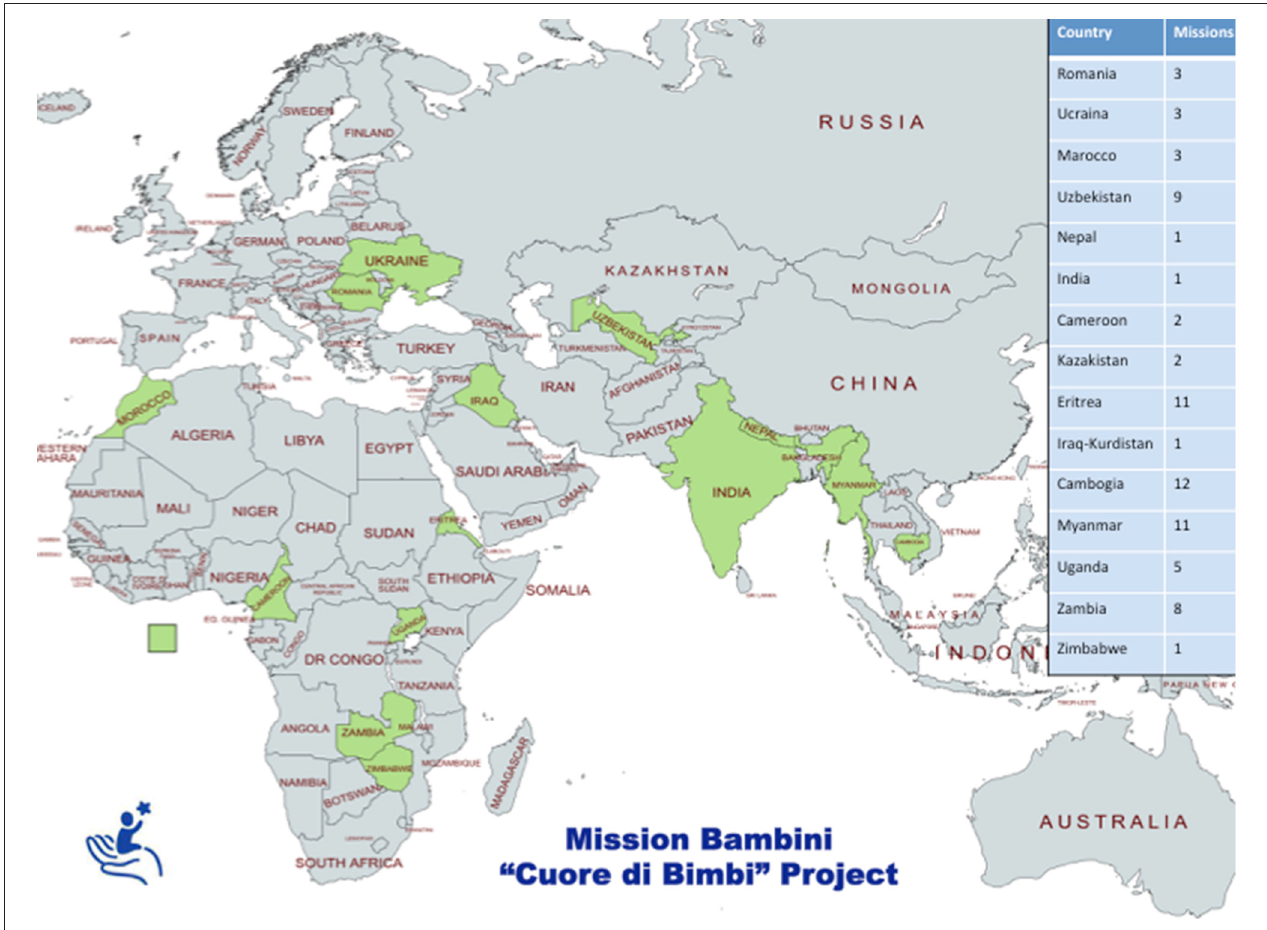
FIGURE 1 | Mission Bambini Cuore di Bimbi